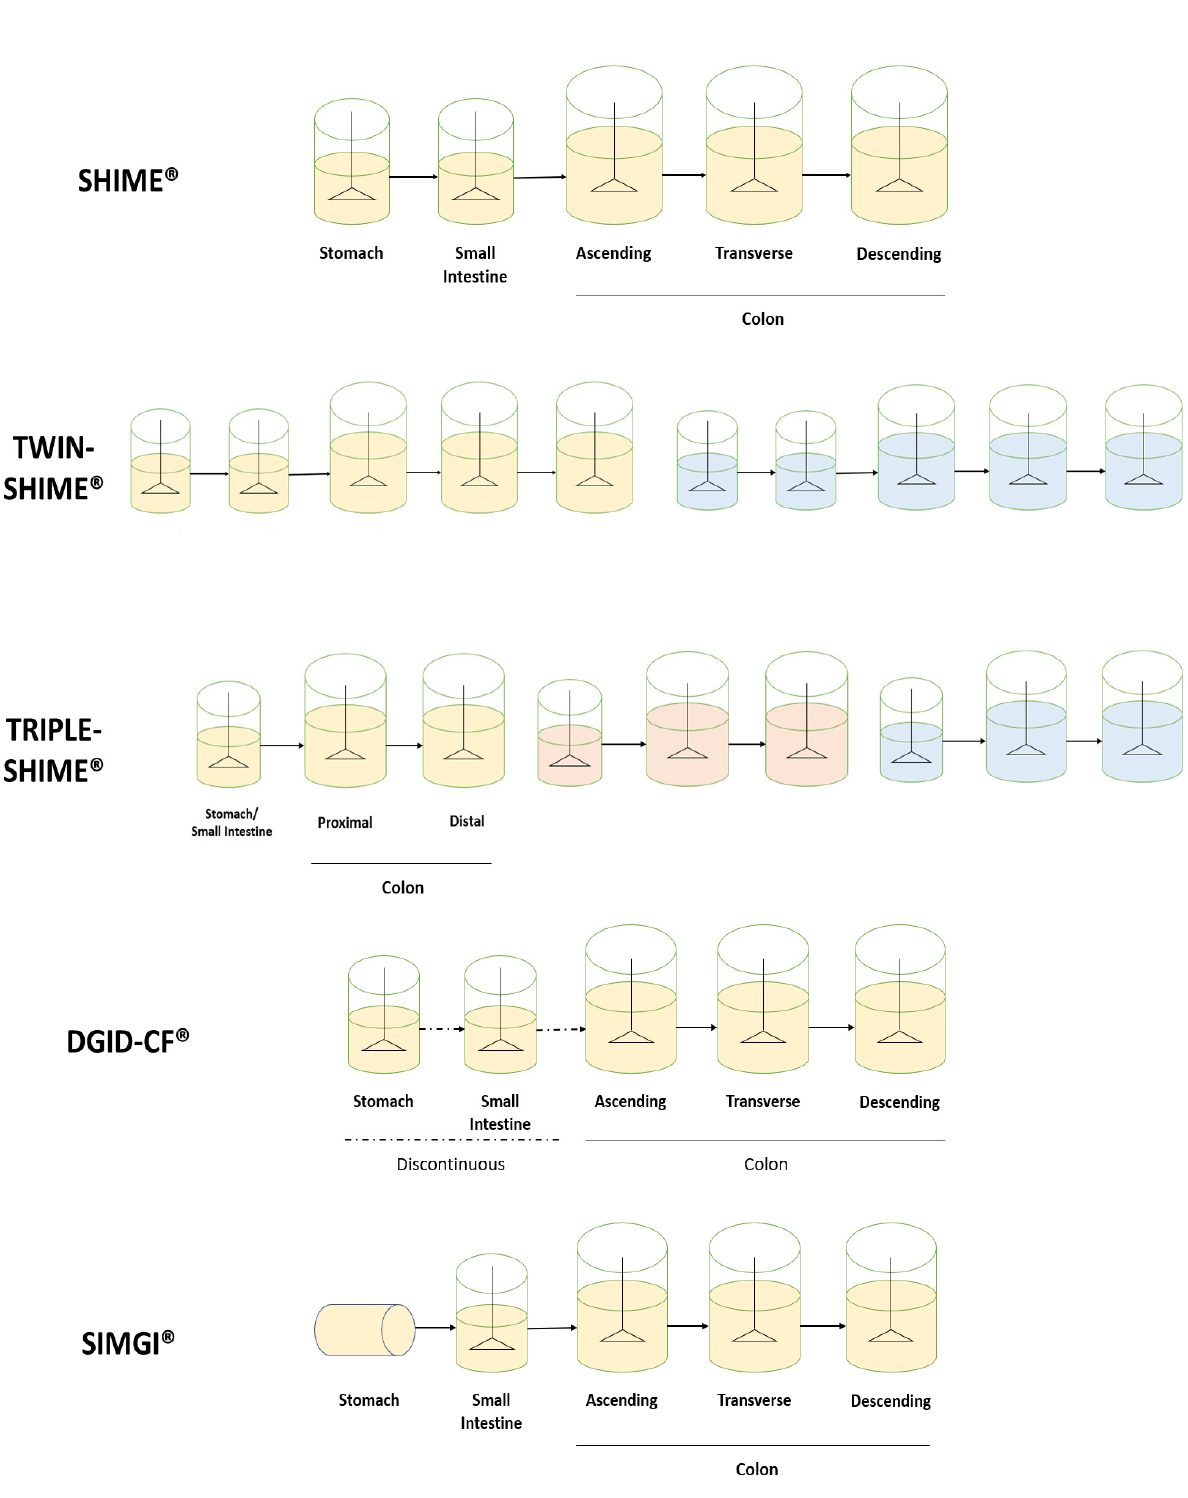
Figure 2. Experimental configurations of the described models.